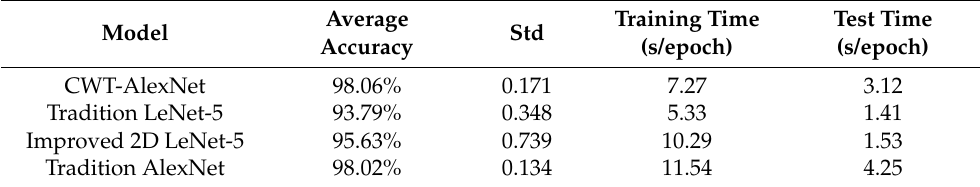
Table 4. Comparison with different